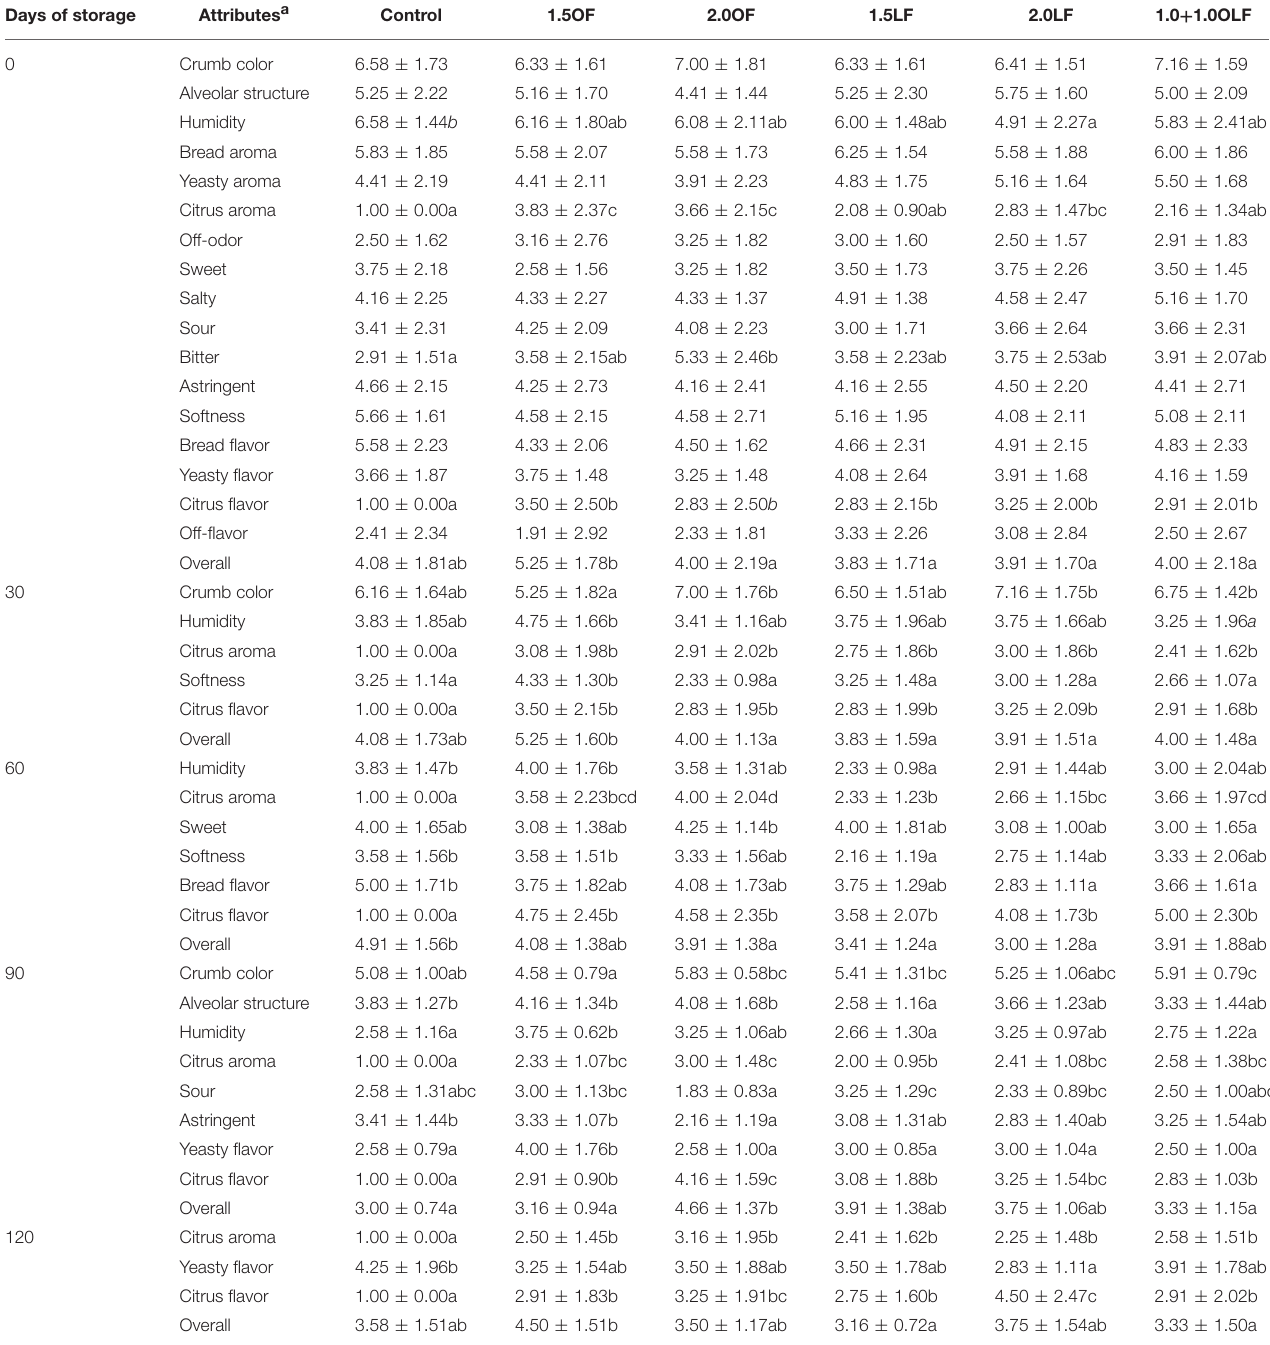
TABLE 9 | Mean scores of the sensory attributes at the different days of storage. Days of